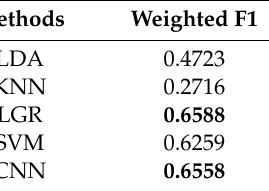
Figure 6. Classification results using FNC matrix. Using the data of the subjects in the multi-object tracking (MOT) task to calculate the Pearson correlation coe ffi cient to obtain the FNC matrix which is used as the input of the classifier. Since the FNC matrix itself is not a time course, so we chose CNN as the representative of the deep learning model for classification. Table 5. Weighted F1 of the methods in FNC